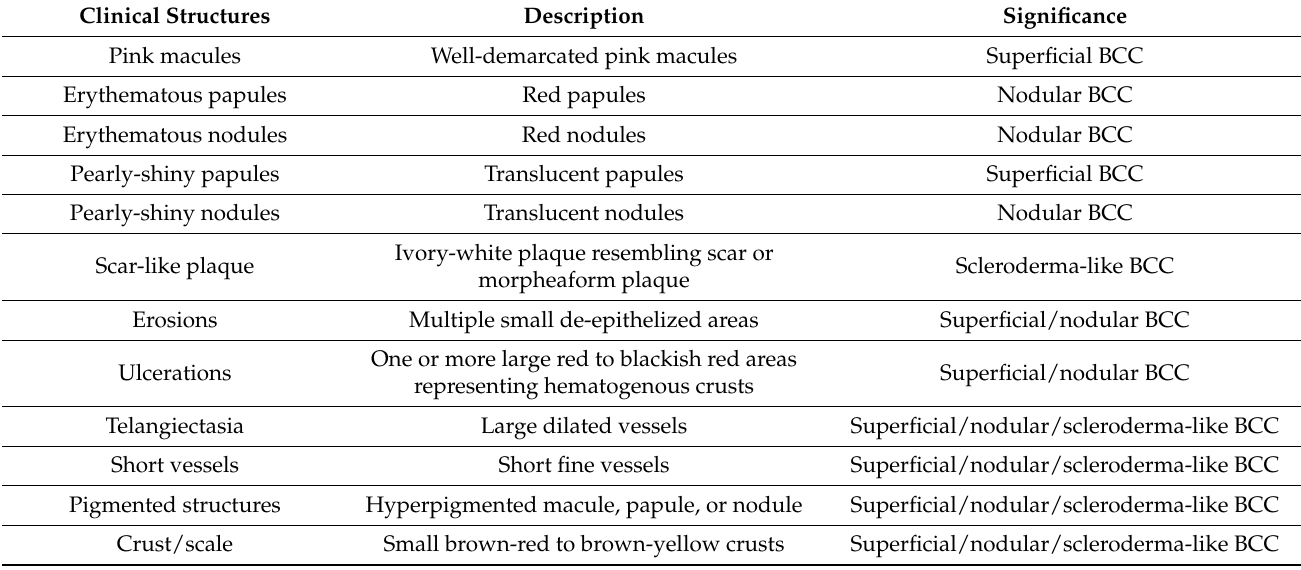
Table 2. Clinical structures of BCC according to Tognetti classification